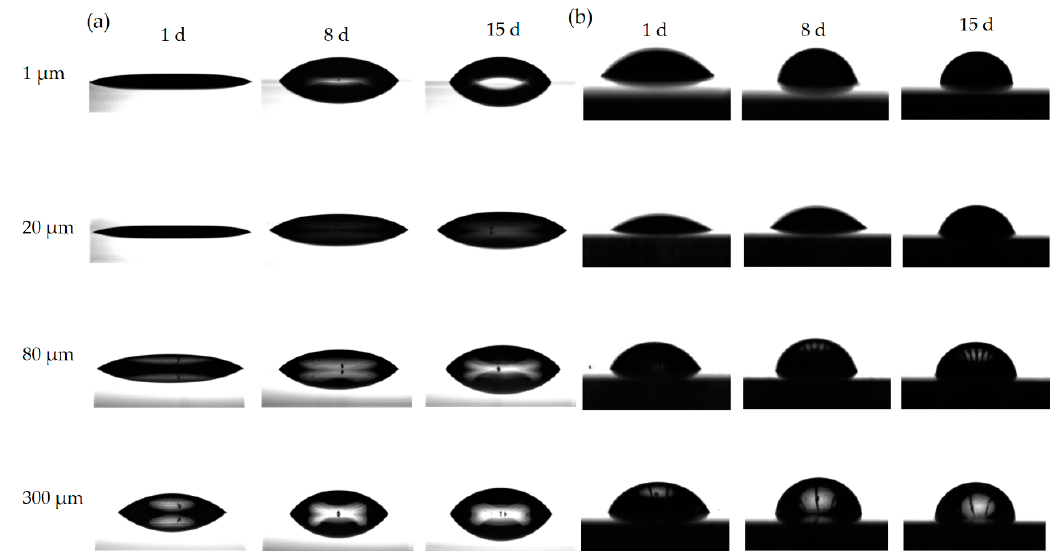
Figure 4. Selected image of the wetting state of structured surfaces over time with different strut widths. ( a ) Contact angles Θ Ʇ in the perpendicular direction and ( b ) contact angles Θ ‖ in the parallel direction.